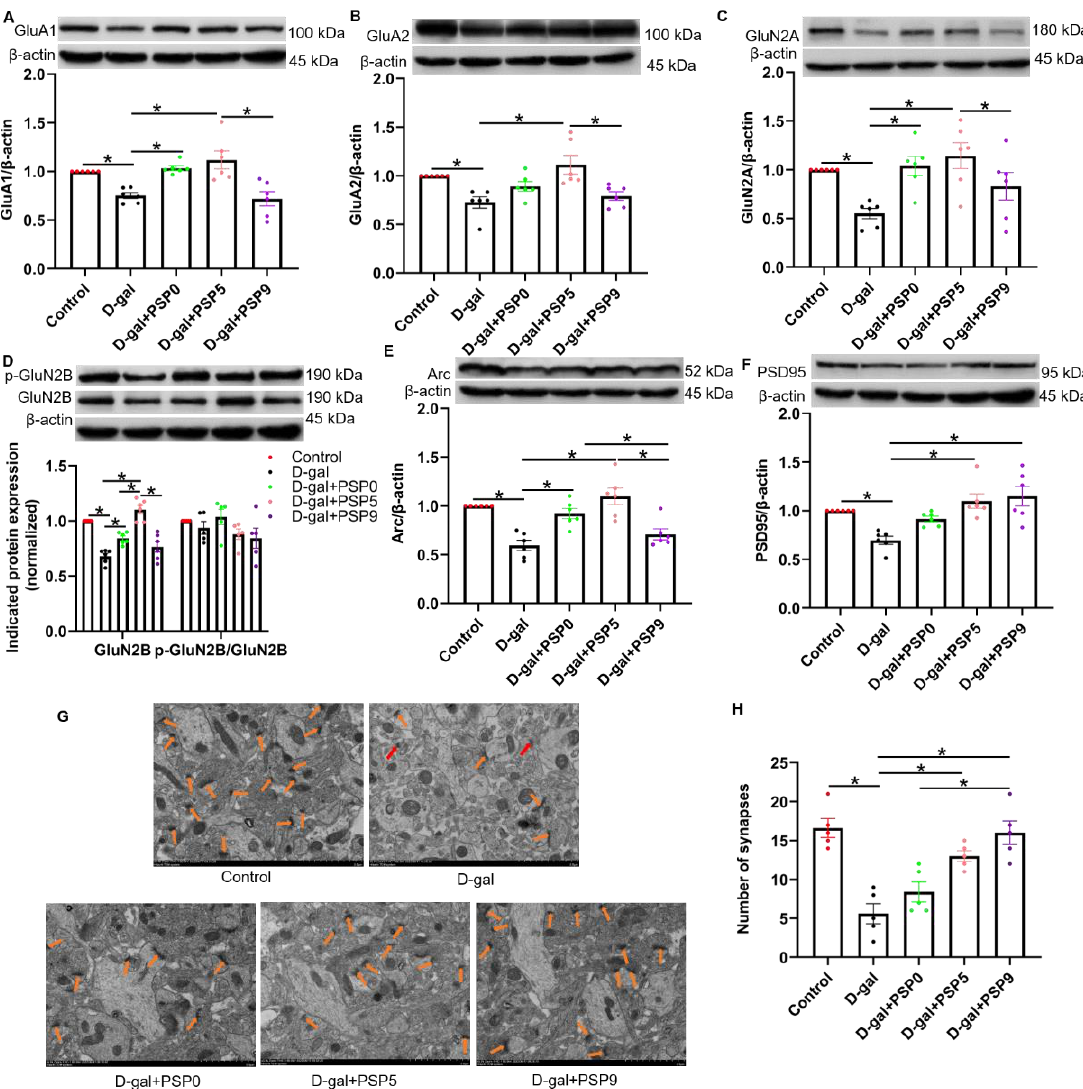
Figure 7. Steamed PSPs ameliorate D-gal-induced hippocampal synaptic deficits. ( A - F ) The upper panels show representative blots of Arc/β - actin, GluA1/β - actin, GluA2/β -actin, GluN2A/β -actin, GluN2B/β -actin, p-GluN2B/GluN2B, and PSD95/β - actin, while the lower panel shows Arc/β -actin, GluA1/β - actin, GluA2/β -actin, GluN2A/β - actin, GluN2B/β -actin, p-GluN2B/GluN2B, and PSD95/β - actin quantification data ( n = 6). ( G ) Representative images of synaptic structure in hippocampal area CA1 (Magnification: x 5000). Red arrows indicate the synapses. ( H ) Number of synapses (12 μm 2 ) ( n = 5). Data are expressed as means ± SEM. * p < 0.05.